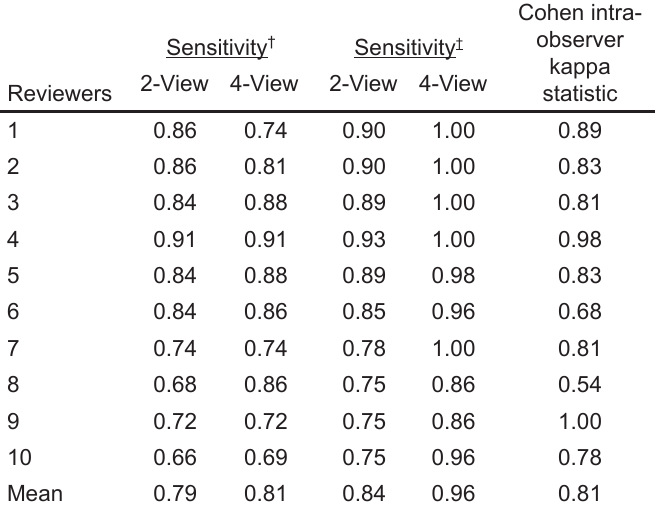
Table 2. Comparison of diagnostic